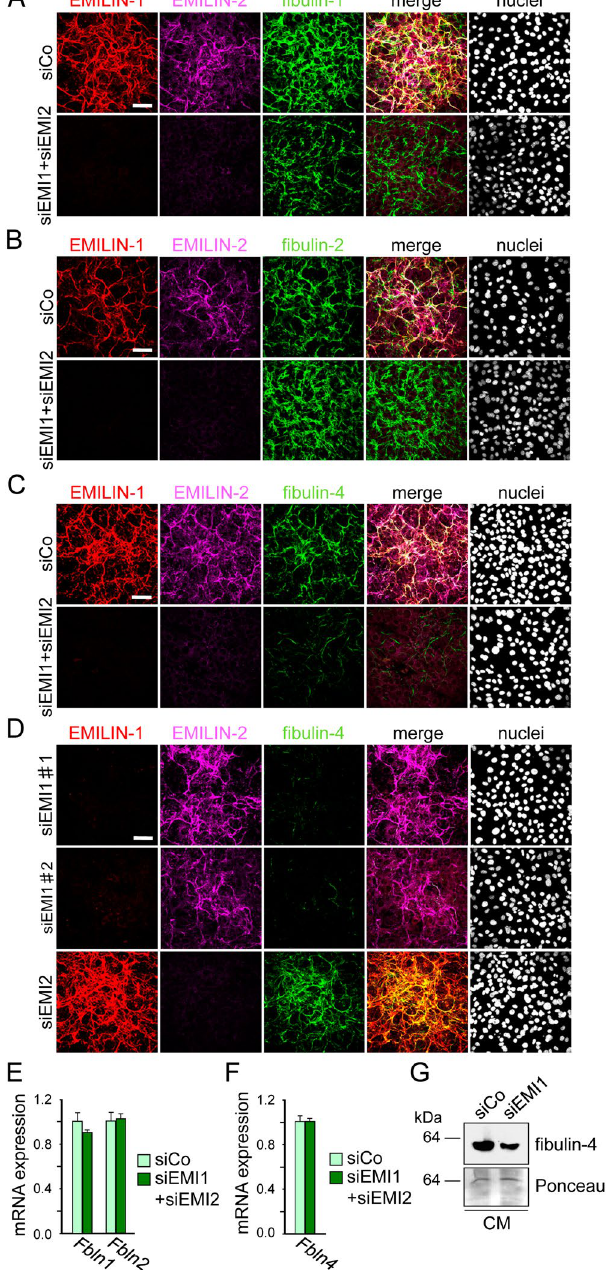
Figure 4. EMILIN-1 knockdown impairs the deposition of fibulin-4 in the ECM of MC3T3-E1 cells. ( A , B ) Expression and deposition of fibulin-1 and fibulin-2 in MC3T3-E1 cells after double knockdown for EMILIN-1 and EMILIN-2. MC3T3-E1 osteoblasts were reverse transfected with a mixture of siRNAs against EMILIN-1 (siEMI1) and EMILIN-2 (siEMI2) or with a control siRNA (siCo) and grown for 4 days. Confocal immunofluorescence microscopy of cells transfected with the different siRNAs and immunolabeled with antibodies against fibulin-1 ( A ) or fibulin-2 ( B ). Nuclei were stained with Hoechst. Scale bar, 75 μ m. ( C , D ) Confocal immunofluorescence microscopy of cells for fibulin-4 after double knockdown of EMILIN-1 and EMILIN-2 ( C ), or single knockdown of EMILIN-1 or EMILIN-2 ( D ). Nuclei were stained with Hoechst. Scale bar, 75 μ m. siEMI1#1 and siEMI1#2 represent two different siRNA sequences targeting EMILIN-1. ( E ) qRT-PCR analysis of Fbln1 , Fbln2 and Fbln4 transcripts in cells transfected with the different siRNAs showed no significant differences (n = 3). G . Western blot analysis for fibulin-4 in conditioned medium (CM) of cells transfected with the different siRNAs. Protein loading is shown by Ponceau staining. All siRNA knockdown experiments were performed three times (n =